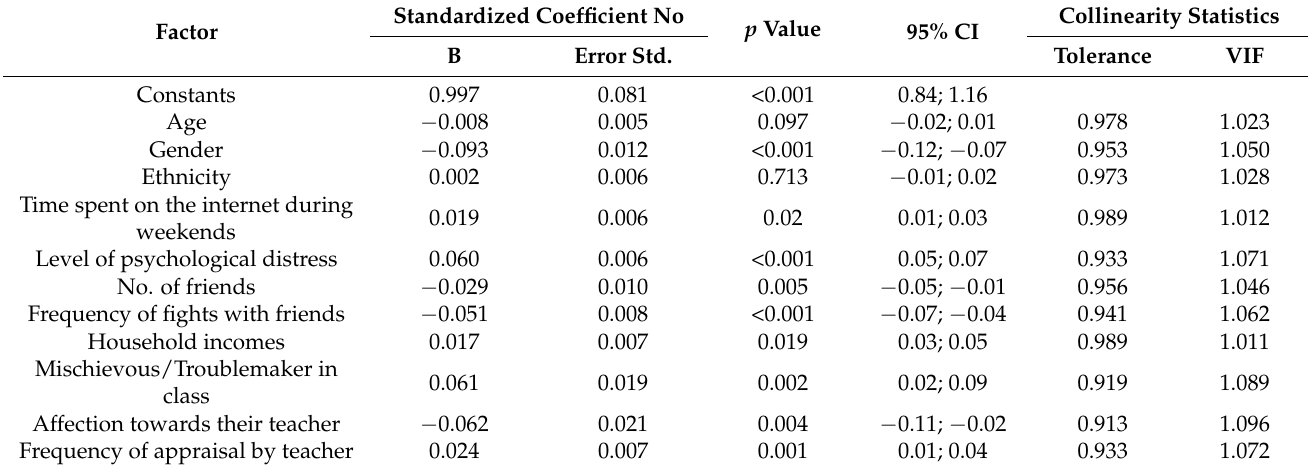
Table 9. Collinearity diagnosis via variance inflation factor.